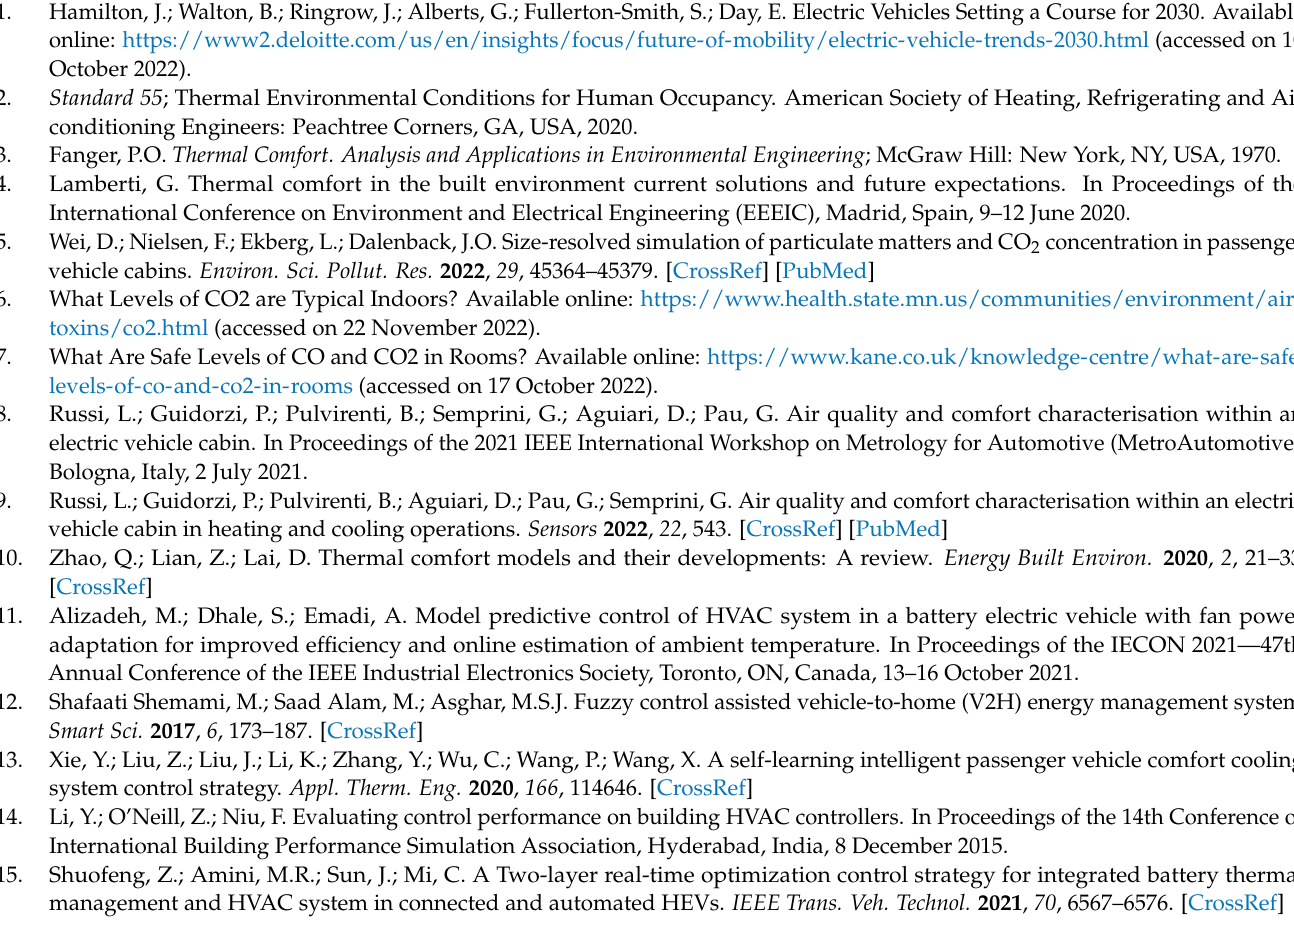
Figure A2. Fuzzy logic membership function of the PMV index and CO 2 concentration designed to regulate the HVAC system recirculation flap. Figure A2 illustrates the mapping of the PMV index and CO 2 concentration to control the recirculation flap of the vehicle HVAC system through fuzzy rules. As described in Figure A2, based on the CO 2 concentration fluctuations, the recirculation flap will be opened or closed accordingly. When the CO 2 concentration inside the vehicle cabin reached 650 ppm, the recirculation flap opened (High (0.75–1)) to allow more fresh air flow into the vehicle cabin. As such, a better cabin IAQ can be maintained in terms of CO 2